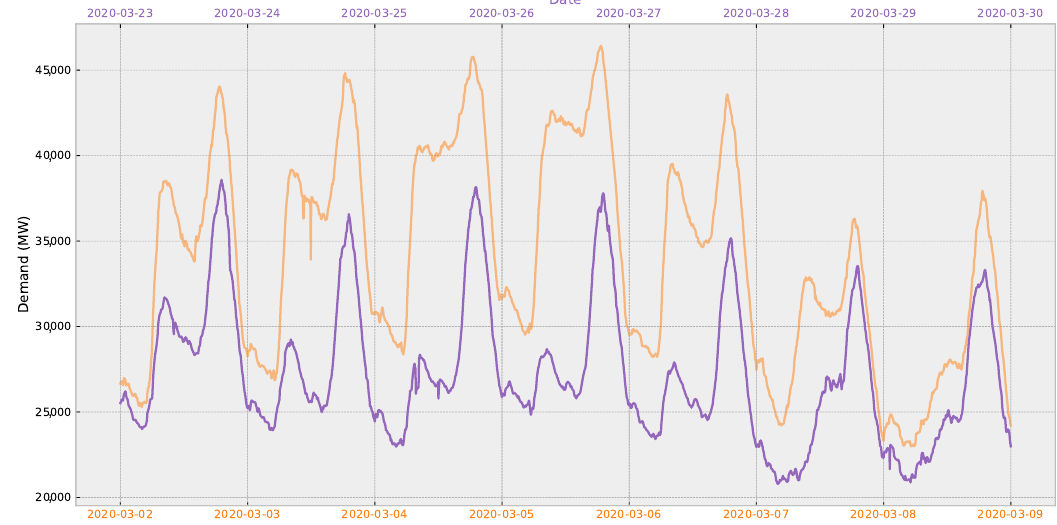
Figure 2. Aggregated system demand before (w/c 02/03/20) and after (w/c 23/03/20) the coronavirus 2019 (COVID-19) actions. Changes are observed in demand magnitude and profile with decreased demand after the